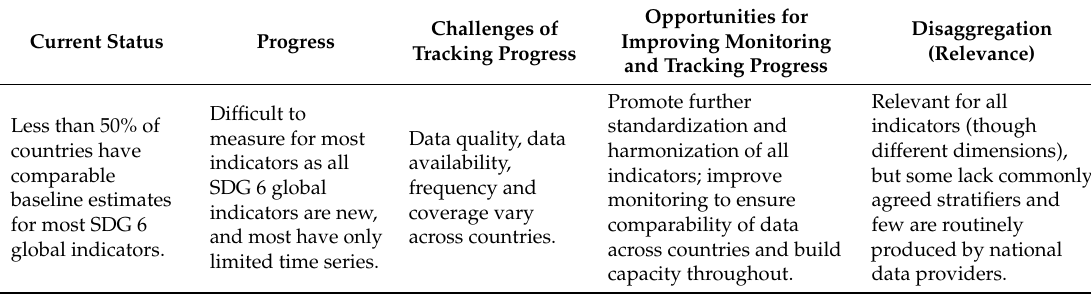
Table 2. Summary of SDG 6 indicator status (Adapted from